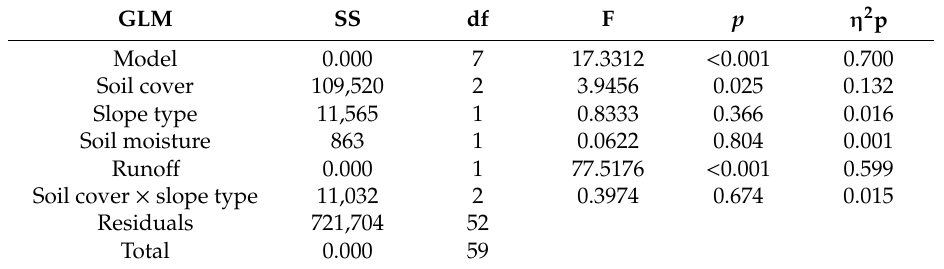
Table 3. Summary results of the general linear model (GLM) involving all measured influencing factors.